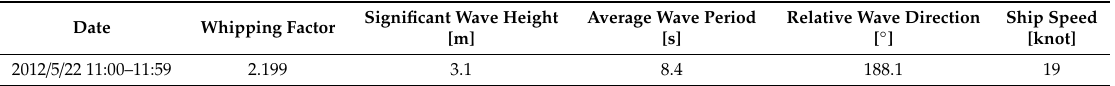
Table 5. Sea state in which a large whipping factor was